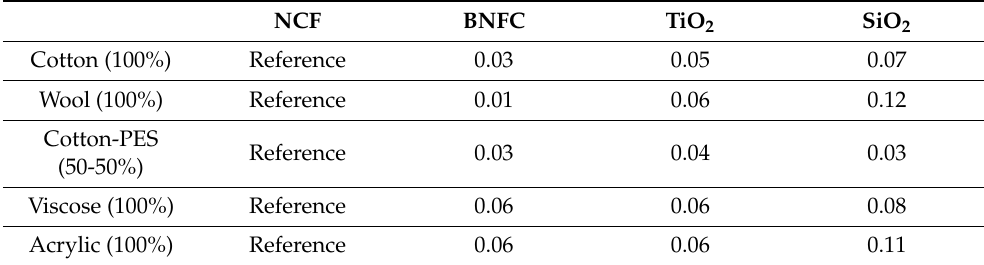
Table 4. Differential contributions of emissivity ∆ ε IR calculated from the ATR-FTIR absorbance spectra using Equation